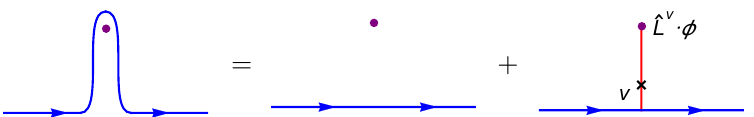
Figure 17 . Moving a TDL L (blue) past a bulk local operator (cid:30) (purple) that satis(cid:12)es (2.16). The third diagram captures all the contributions involving non-identity TDLs attached to L via a junction vector v .